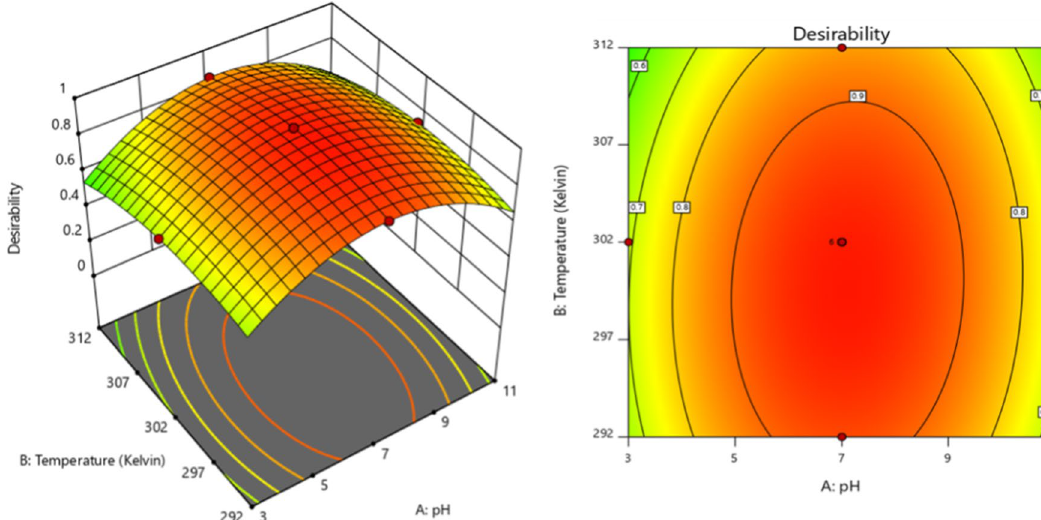
Fig. 23 3D Surface plot of desirability of Q Fig. 24 Boundary layer diffu- sion phenomena in